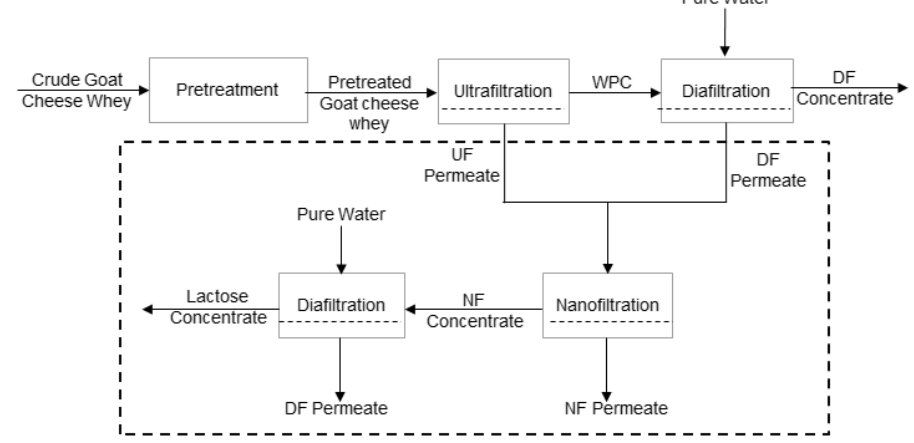
Figure 1. Schematic representation of the processes involved in this work.